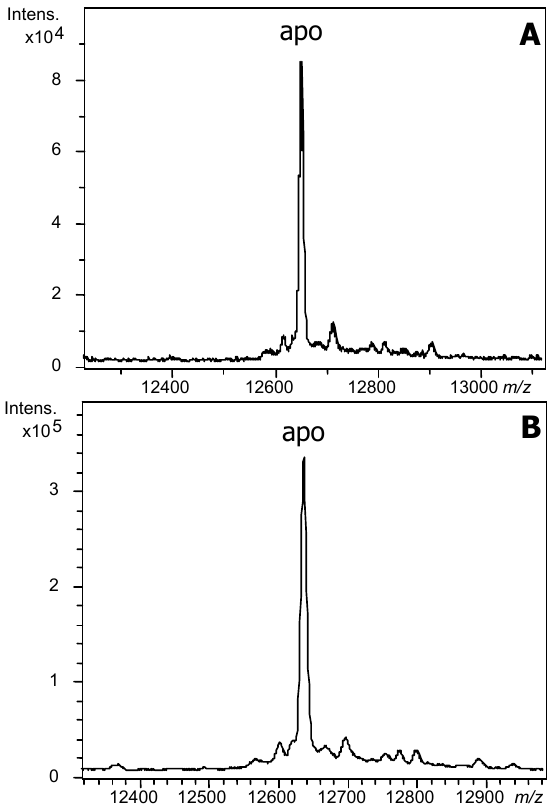
Figure 2. MS spectra of BgMT proteins: Deconvoluted electrospray ionization mass spectrometry (ESI-MS) spectra of the bacterial recombinant production of ( A ) BgwtMT (Experimental Molecular Mass: 12,652) and ( B ) BgKNMT (Experimental Mass: 12,639) in Zn-enriched media, recorded at pH 2.4.